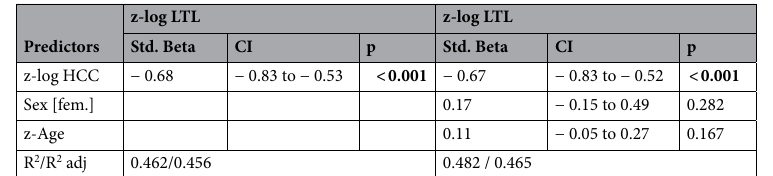
Table 2. Linear regression model predicting standardized z-log LTL by z-log HCC (N = 92). Significant values are in bold. z-log natural logarithm and standardization, LTL leukocyte telomere length, HCC hair cortisol